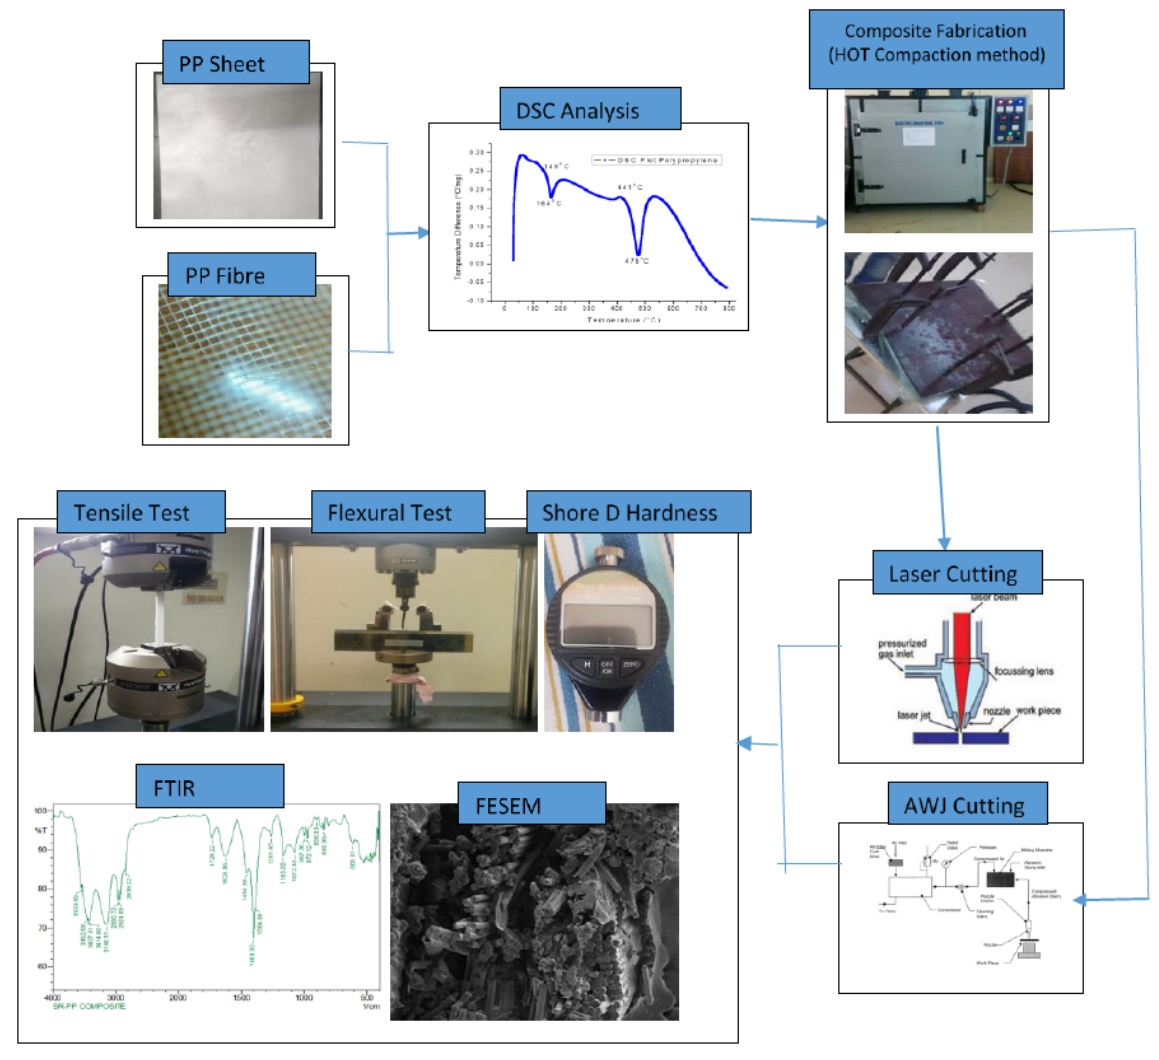
Figure 2: Schematic diagram of fabrication and testing